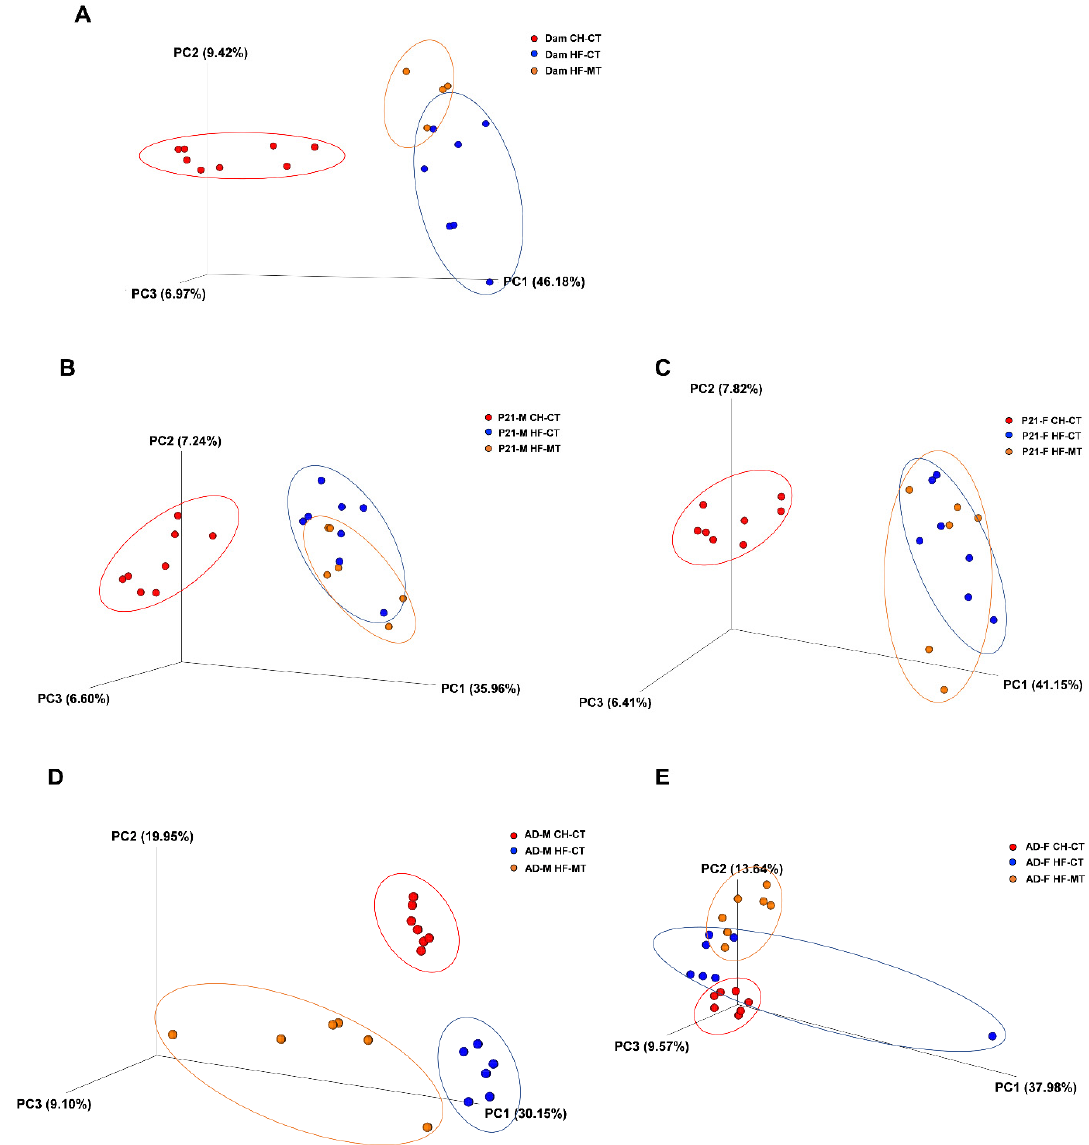
Figure 5. Maternal metformin treatment reshapes the gut microbiota composition in dams and offspring: ( A ) principal coordinates analysis (PCoA) 3D plot of unweighted UniFrac distances in 16S rRNA sequencing of fecal contents in dams at weaning; ( B , C ) PCoA 3D plots of 16S rRNA sequencing of colonic contents in male and female offspring at weaning; ( D , E ) PCoA 3D plots of 16S rRNA sequencing of colonic contents in male and female offspring at 16 weeks old. Each dot represents data from one rat; CH ‐ CT, n = 7–8; HF ‐ CT, n = 6–8; HF ‐ MT, n = 4–7.